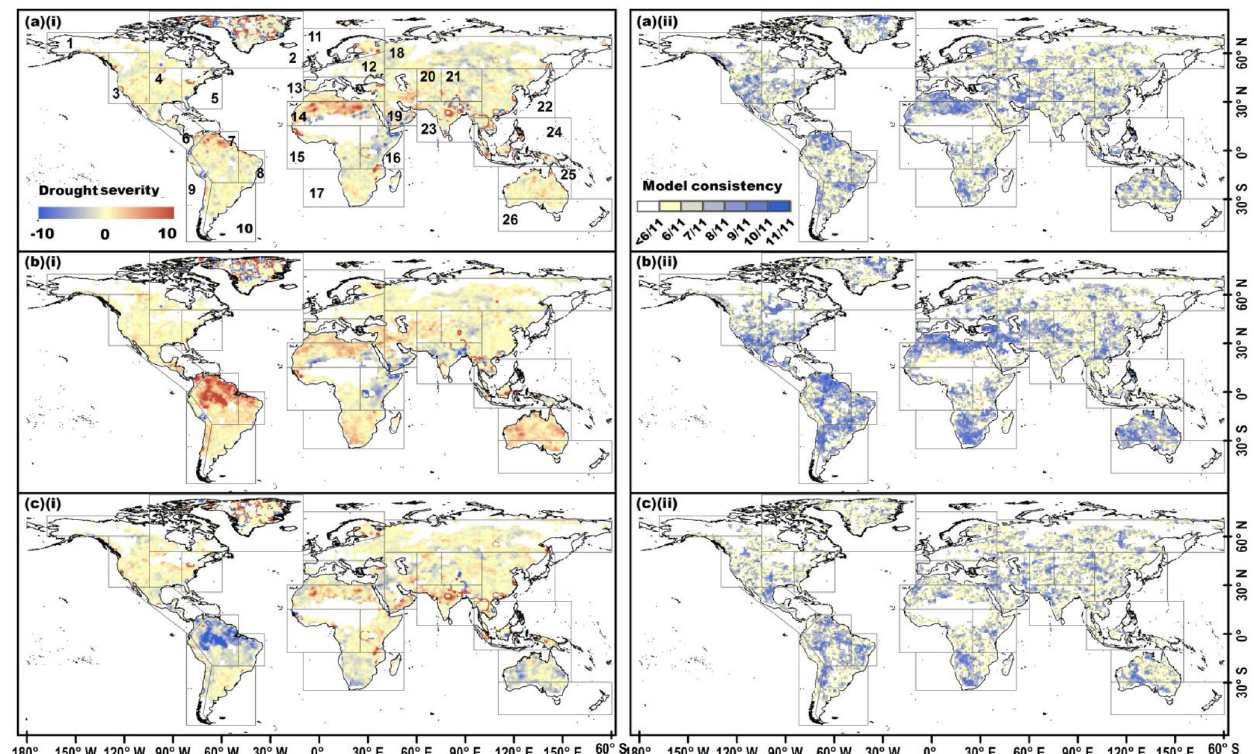
Figure 9. Changes in multi-model ensemble mean drought severity (dimensionless) (i) and model consistency (ii) on a spatial resolution of 0.5 ◦ × 0.5 ◦ . Panel (a) is from the baseline period to the 1.5 ◦ C warmer world, panel (b) is from the baseline period to the 2 ◦ C warmer world and panel (c) is (a) – (b) . The gray boxes show the regions adopted by IPCC (2012), which are labeled in (a)(i) using the ID numbers defined in Table 2. The legend in (a)(i) applies to (b)(i) and (c)(i) and the legend in (a)(ii) applies to (b)(ii) and (c)(ii)